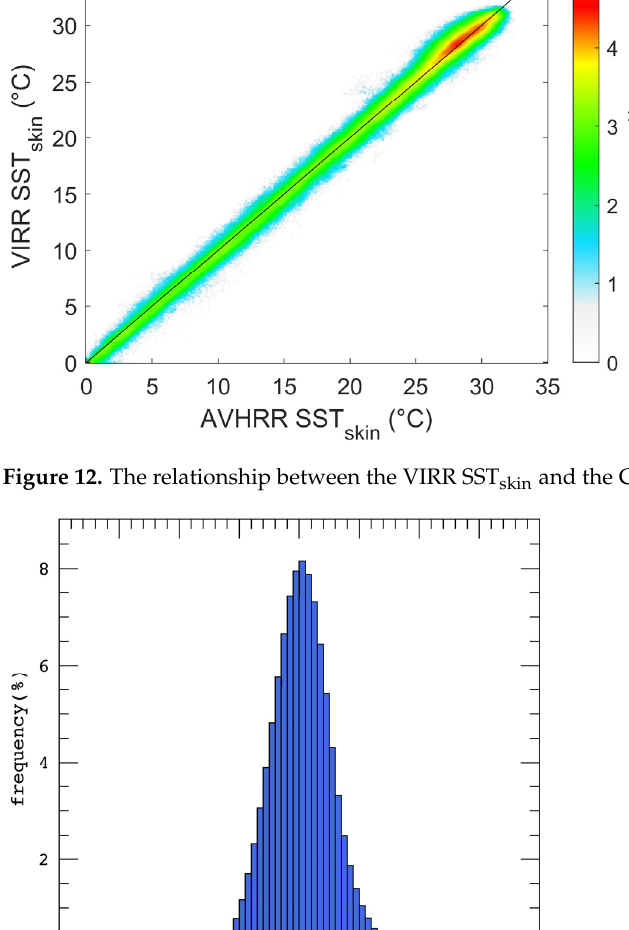
14 of 18 Figure 11. Histogram of bias of VIRR SST skin and buoy SST. MetOp-A AVHRR SST skin from CCI project are used to evaluate the VIRR SST skin . Since both the SST skin data are obtained by the OE are skin temperature, the descending nodes of the two satellites are close. The AVHRR SST skin with the highest quality and VIRR SST skin is projected on the grid of 0.04° × 0.04°. If multiple VIRR SST skin s or AVHRR SST skin s fall in the same grid, they will be averaged. The temporal window for matching between the VIRR SST skin and AVHRR SST skin is 1 h, and the spatial window is 0.04° × 0.04°. There are a total of 6,028,138 matchups between the VIRR SST skin and the AVHRR SST skin , with a bias of 0.08 °C and a standard deviation of 0.55 °C. The correlation coefficient between VIRR SST skin and AVHRR SST skin is 0.9975. Figure 12 shows that the VIRR SST skin and the AVHRR SST skin have good consistency. The histogram of bias of VIRR SST skin with AVHRR SST skin is shown in Figure 13. It shows that the bias of most matchups is distributed near zero, decreasing to both sides. 16% of matchups are